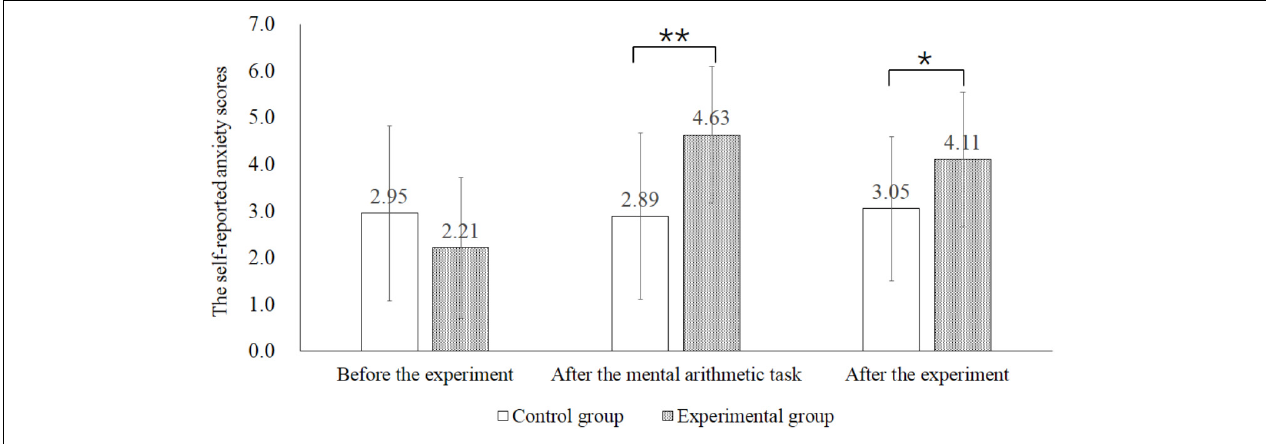
FIGURE 1 | Self-reported anxiety scores in the control and experimental group before the experiment, after the mental arithmetic task and after the experiment. ∗ p < 0.05, ∗∗ p < 0.01.